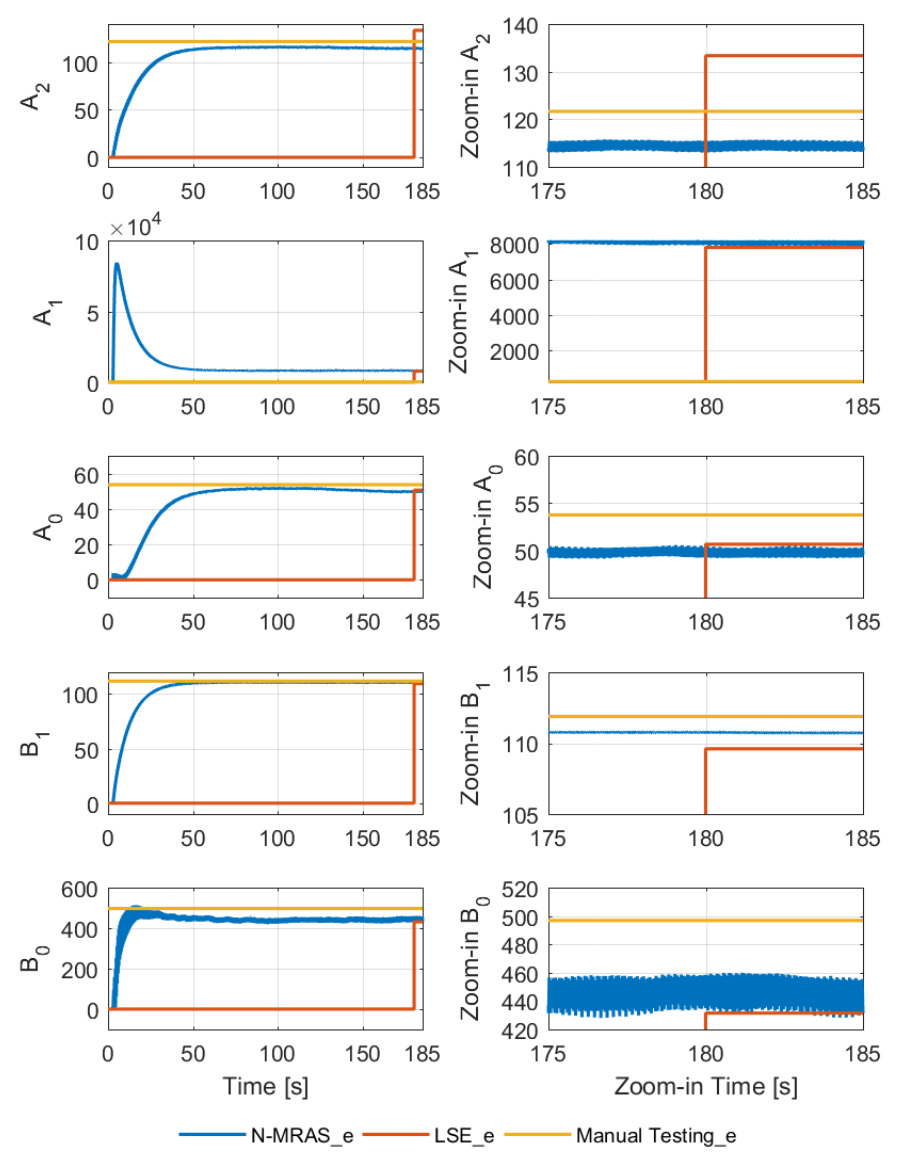
Figure 16. Comparative results for the intermediate electrical parameters estimate, where the right- side graphics are a convenient zoom-in of the left-side